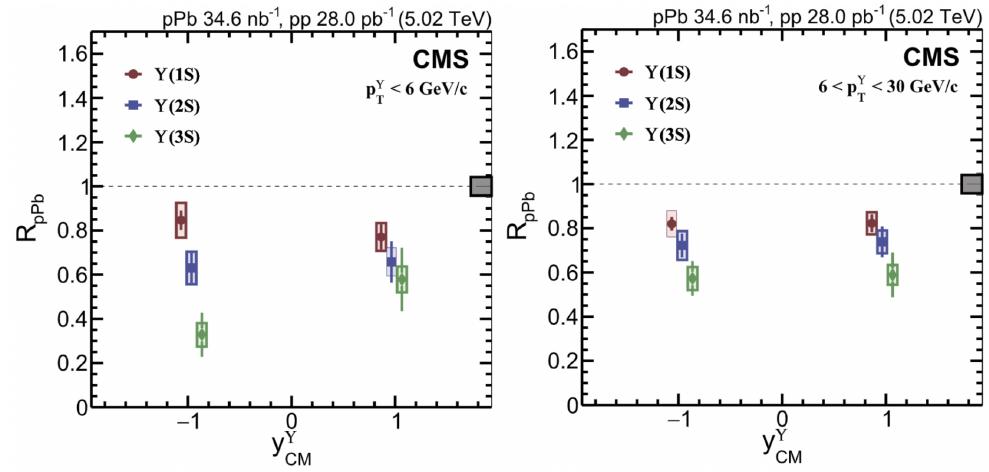
Figure 18. The nuclear modification of Υ ( 1 S ) , Υ ( 2 S ) , and Υ ( 3 S ) in p + Pb collisions as a function of rapidity [84]. The modification is shown for p T < 6 GeV/c ( left ), and 6 < p T < 30 GeV/c ( right ). Reprinted with permission from